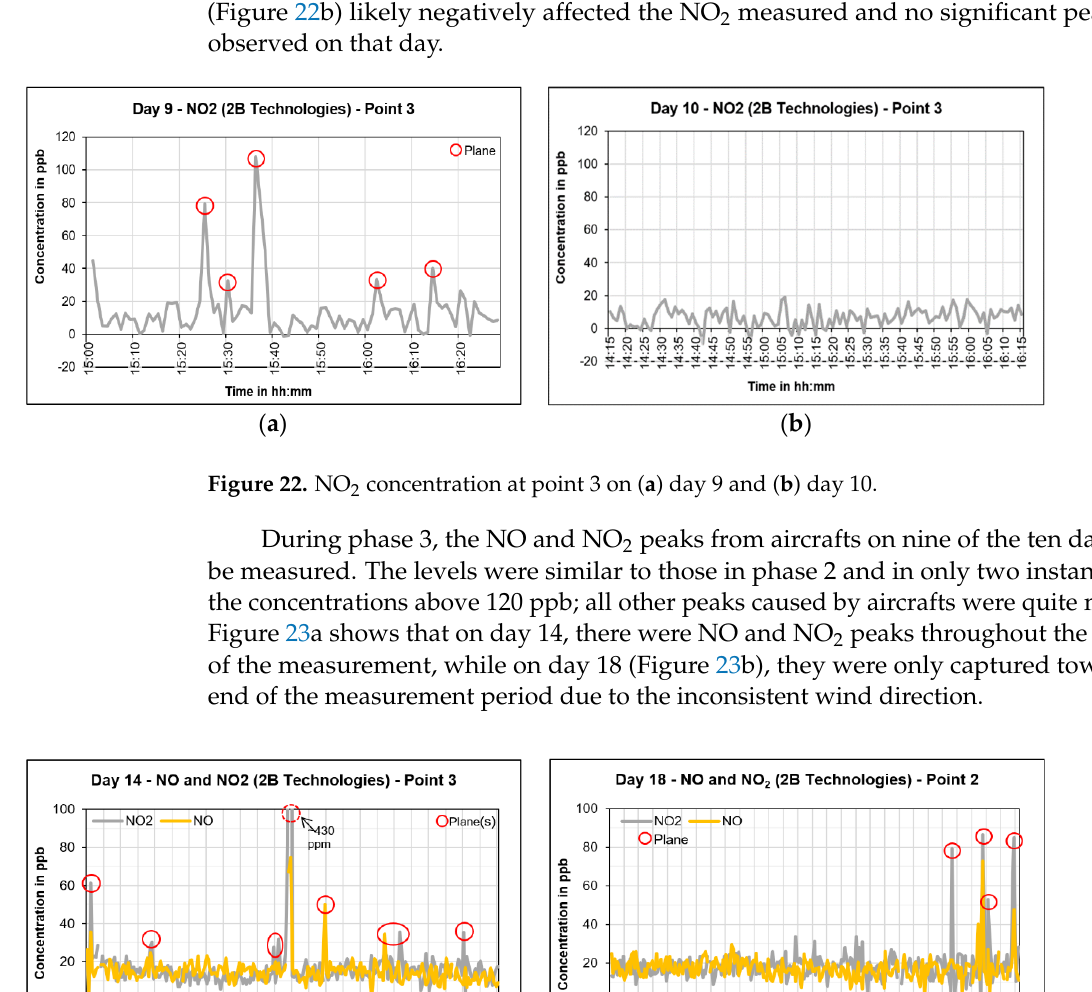
Figure 23. NO 2 and NO concentrations on ( a ) day 14 and ( b ) day 18.